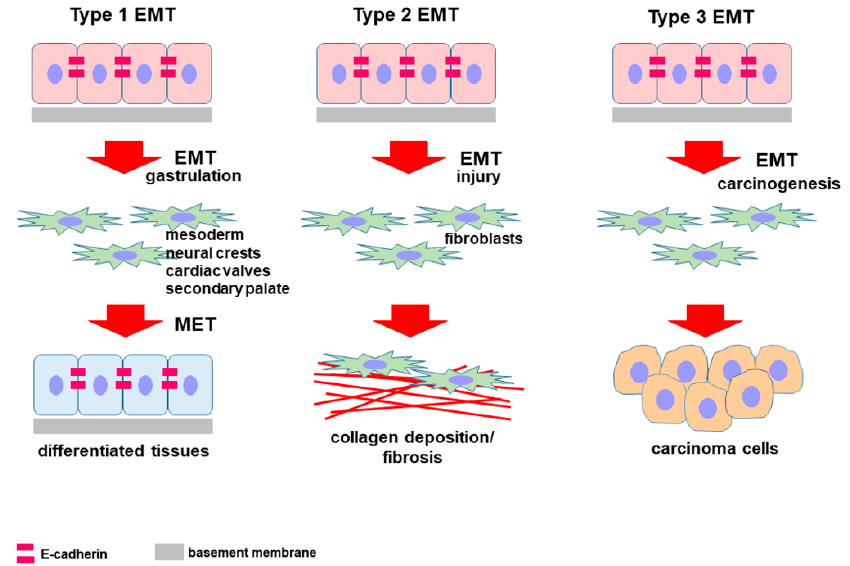
Figure 1. Diagram showing the classification of epithelial-to-mesenchymal transition (EMT) and the di ff erent fate of cells undergoing the EMT program. Type 1 EMT occurs in physiological conditions such as embryogenesis, Type 2 EMT can be described in pathological situations such as fibrogenesis, while Type 3 is a key event in carcinoma progression. Independently of the specific condition, the di ff erent EMT types share a common characteristic: They originate from very motile mesenchymal cells. The diverge for the control and duration of the process but, above all, for the final destination of cells generated by EMT.